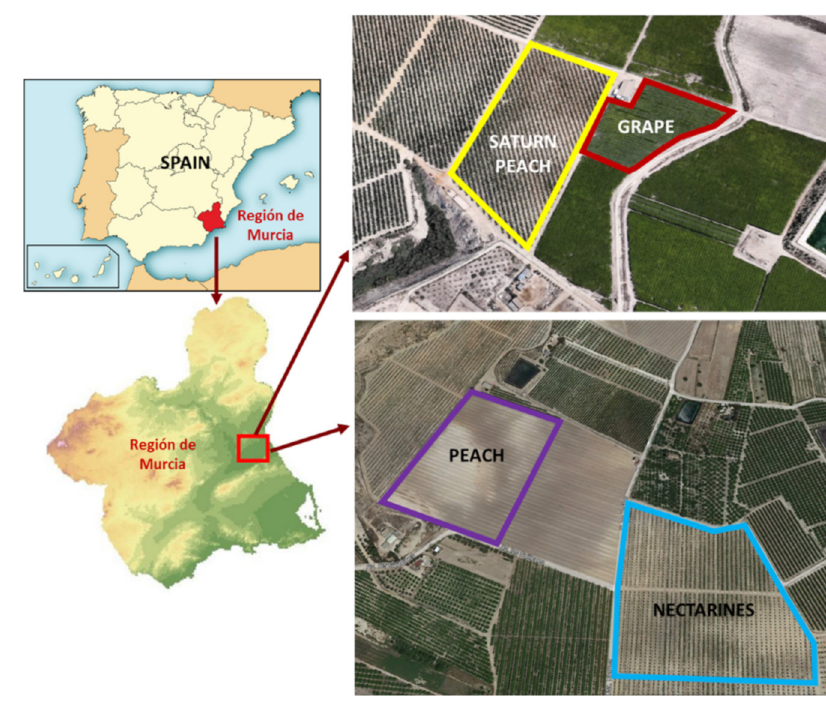
Figure 1. Locations of the selected